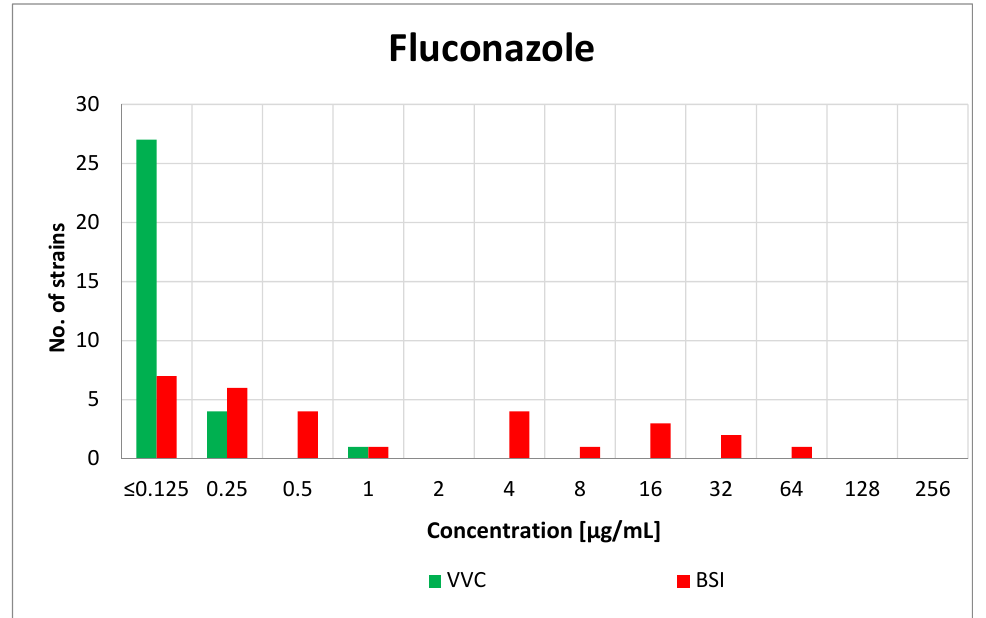
Figure 1. Distribution of the MICs of fluconazole among the vaginal (VVC) and blood-derived (BSI) Candida strains.